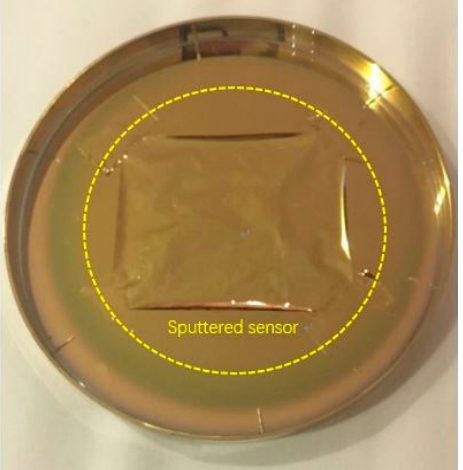
Figure 2. The polyimide film with a thickness of 8 microns on an acrylic dish sputtered with chromium and gold. Electronics 2018 , 7 , x FOR PEER REVIEW